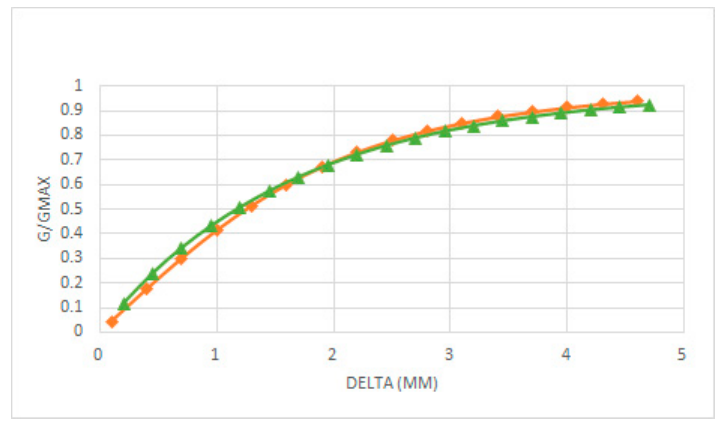
Figure 9. G/Gmax versus δ computed with Coney formula valid for (cid:1864) ≫ (cid:1853) with the characteristics of